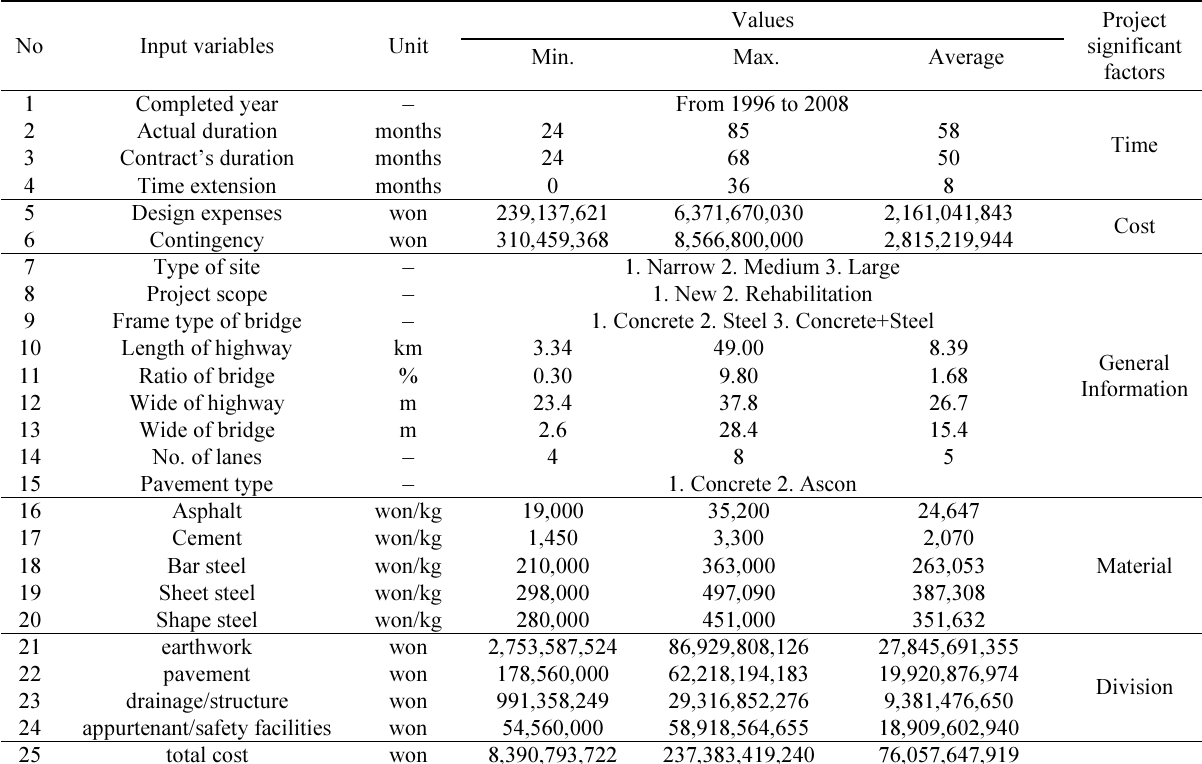
Table 3. Determinants of project